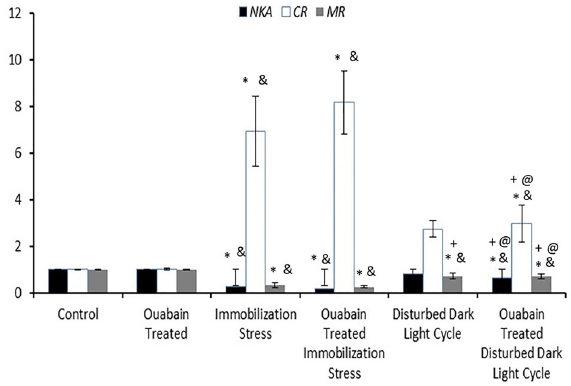
Figure 3. Relative gene expression of hippocampal Na + /K + -ATPase ( NKA ), corticosteroid receptors ( CR ), and melatonin receptors ( MR ) to the housekeeping gene beta-actin of the study groups. Data are reported as means ± SD. *P o 0.05 compared to the control group; & P o 0.05 compared to ouabain-treated group; + P o 0.05 compared to untreated immobilization group; @ P o 0.05 compared to ouabain-treated immobilization group (ANOVA).